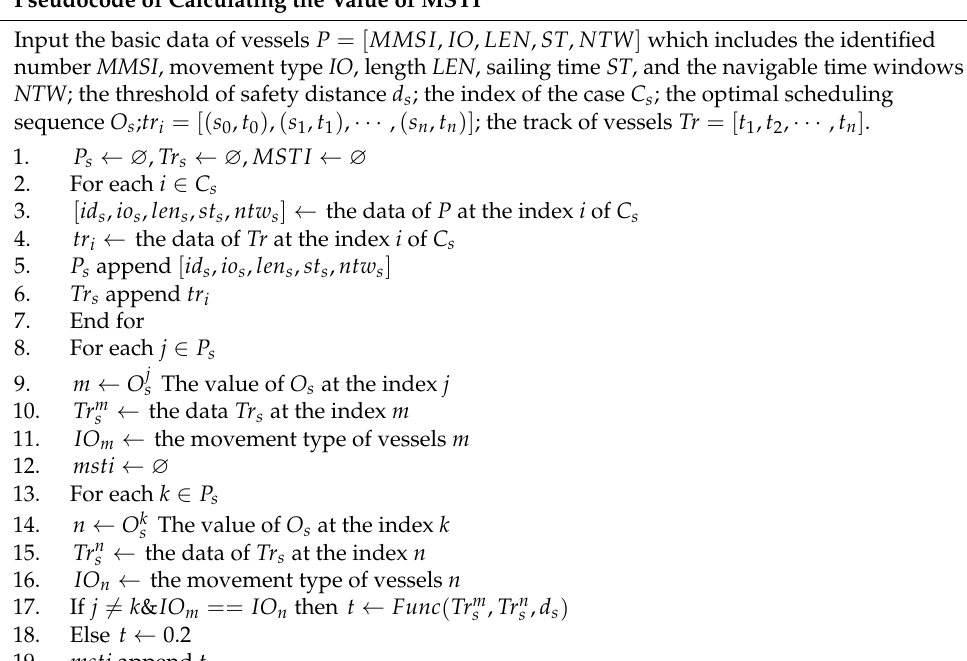
Table A1. Pseudocode of calculating the value of MSTI. Pseudocode of Calculating the Value of